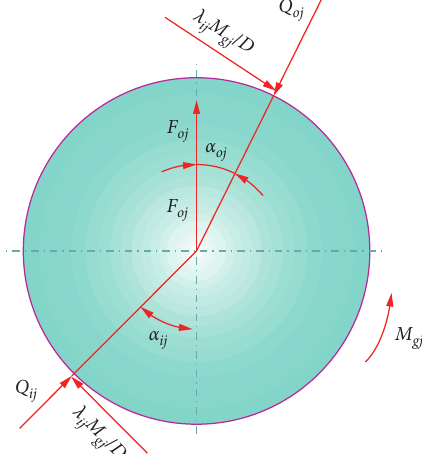
Figure 2: Schematic diagram of the rolling